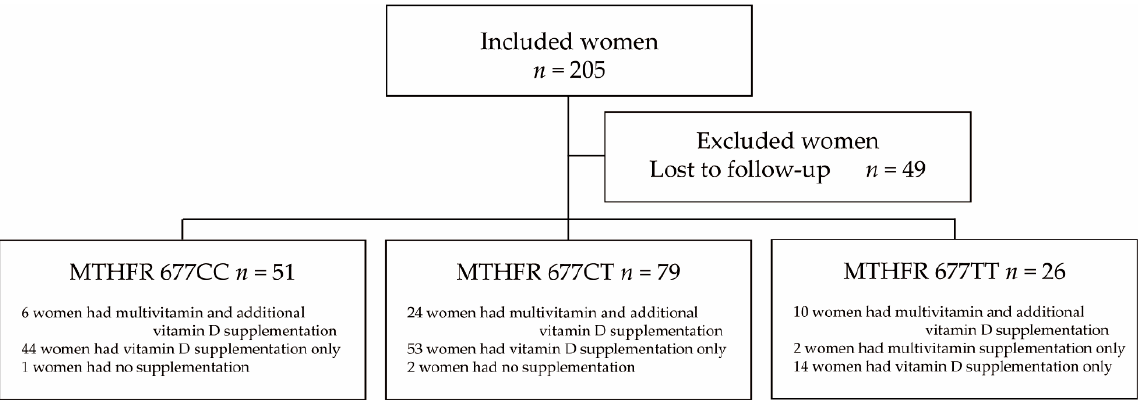
Figure 3. Flowchart of pregnancy outcomes. Of the 205 recruited women, we examined pregnancy outcomes in 51, 79 and 26 women with MTHFR 677CC, CT and TT genotypes, respectively, after excluding 49 without follow-up. Pregnancy outcomes within six months in three MTHFR genotypes were compared.